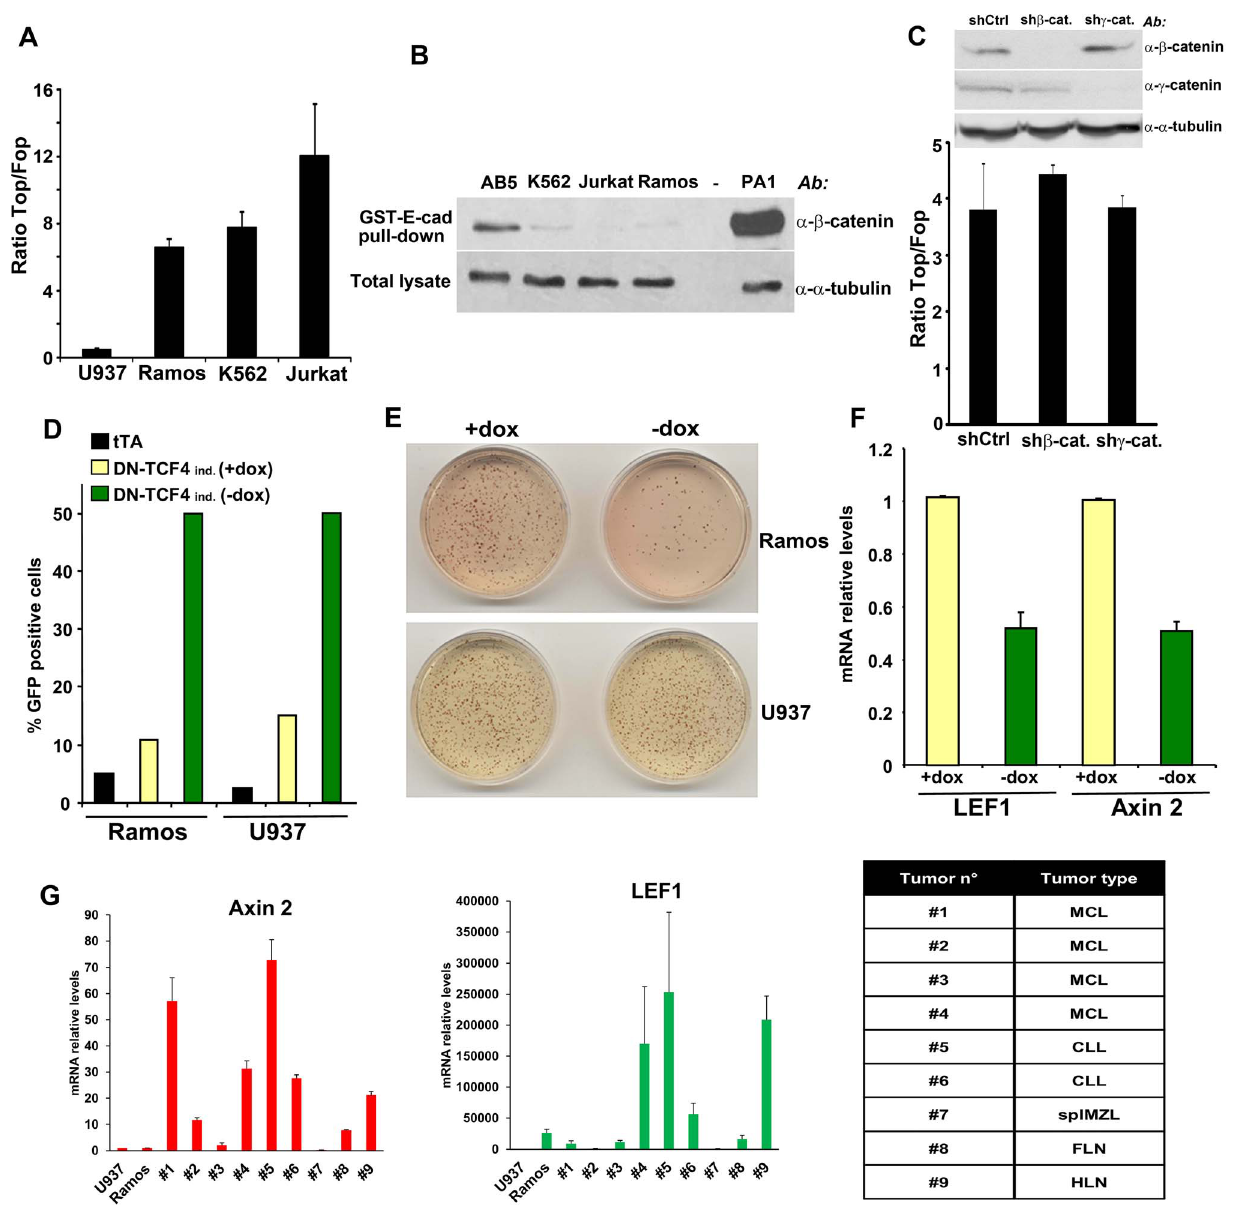
Figure 1. Constitutive TCF/LEF activity in hematopoietic tumor cells in the absence of b -catenin stabilization. (A) The indicated hematopoietic tumor cells were transduced with wild-type (Top) or mutant (Fop) TCF/LEF firefly luciferase reporter and a renilla luciferase virus, and the TCF/LEF transcriptional activity was calculated by dividing the TOP/renilla ratio by the FOP/renilla ratio. The mean values ( 6 s.e.m., n . 5) of at least two independent experiments are shown. (B) Lack of b -catenin stabilization in K562, Jurkat and Ramos cells, as measured by GST-E-cadherin pull-down. Ovarian PA1 cancer cells and breast immortalized AB5 cells were used as positive and negative control, respectively. (C) b -catenin or c - catenin knockdown in Ramos cells did not affect TCF/LEF activity. Ramos cells containing Top or Fop luciferase reporter were infected with b -catenin or c -catenin shRNA and the TCF/LEF reporter activity was measured (lower panel). b -catenin and c -catenin down-regulation was assessed by immunoblot (upper panel). (D) Ramos and U937 cells containing the tet transactivator (tTA) with or without a lentiviral inducible vector containing DN-TCF4 fused to GFP were cultured for 24 hrs in the presence or the absence of doxycycline (dox), and the proportion of GFP positive cells was assessed by FACS analysis. (E) The cells in D were used in colony formation assay in the presence or the absence of dox. (F) Effects of DN-TCF4 induction in Ramos cells on the expression of LEF1 and Axin 2 by quantitative real-time PCR. (G) mRNA levels of Axin 2 and LEF1 in human primary hematopoietic tumors. For each sample, the qPCR values were normalized with those obtained for the negative control, U937 cells. The types of malignancy corresponding to each sample are listed in the table: MCL, mantle cell lymphoma; CLL, B-cell chronic lymphocytic leukemia; splMZL, splenic marginal zone lymphoma; FLN, follicular lymphoma; HLN, Hodgkin’s lymphoma.